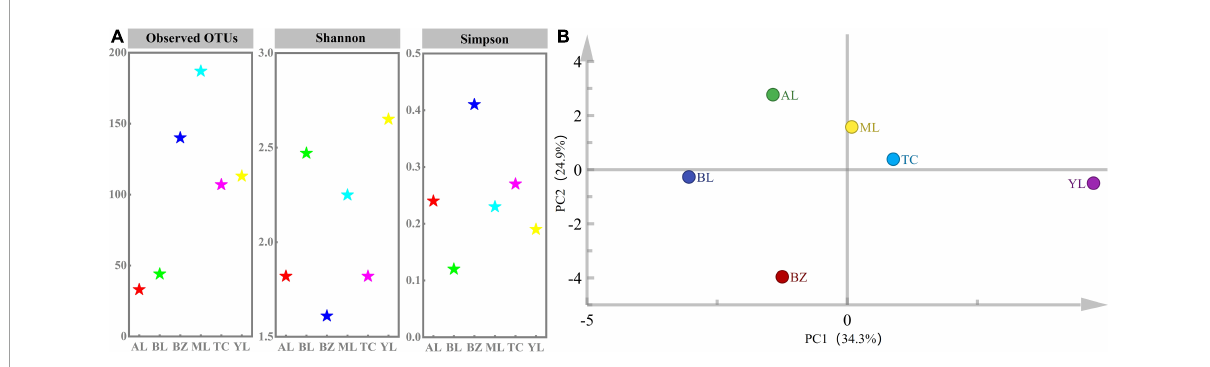
FIGURE1 Alpha diversity (A) and principal component analysis (PCA) (B) of smoked horsemeat sausages from different regions of Xinjiang based on bacterial